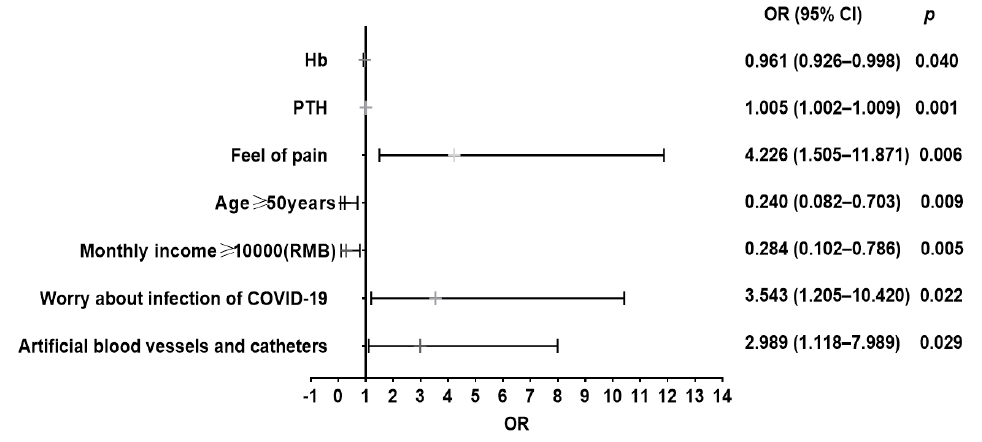
Figure 5. Logistic analysis of risk factors of anxiety in the MHD patients.